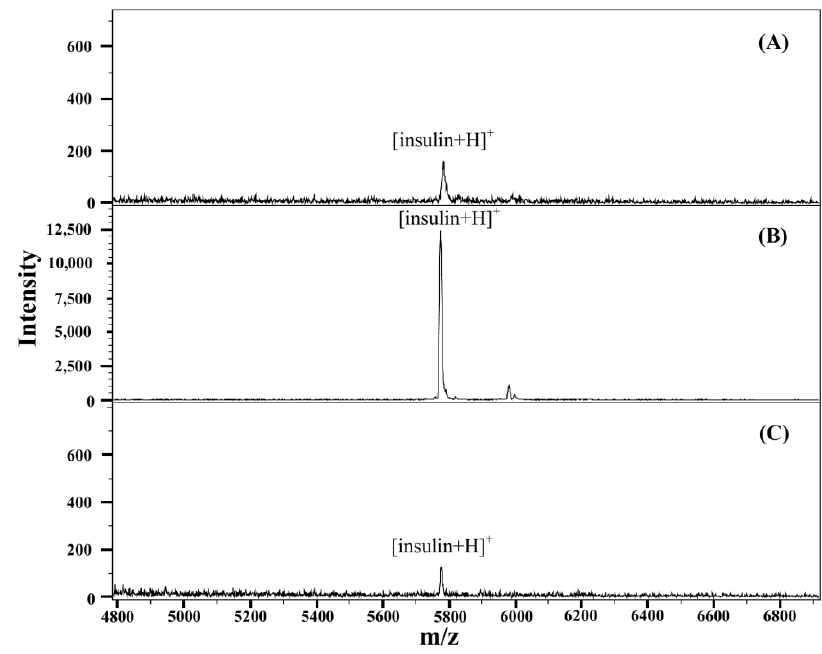
Figure 7. Mass spectra of ( A ) insulin (50.0 nM) obtained without the EME, ( B ) insulin (50.0 nM) obtained with the EME, and ( C ) insulin (1.0 nM) obtained with the EME. Experimental conditions: sample volume, 12 mL; applied voltage, 12 V; agitation rate, 400 rpm; and extraction time, 10